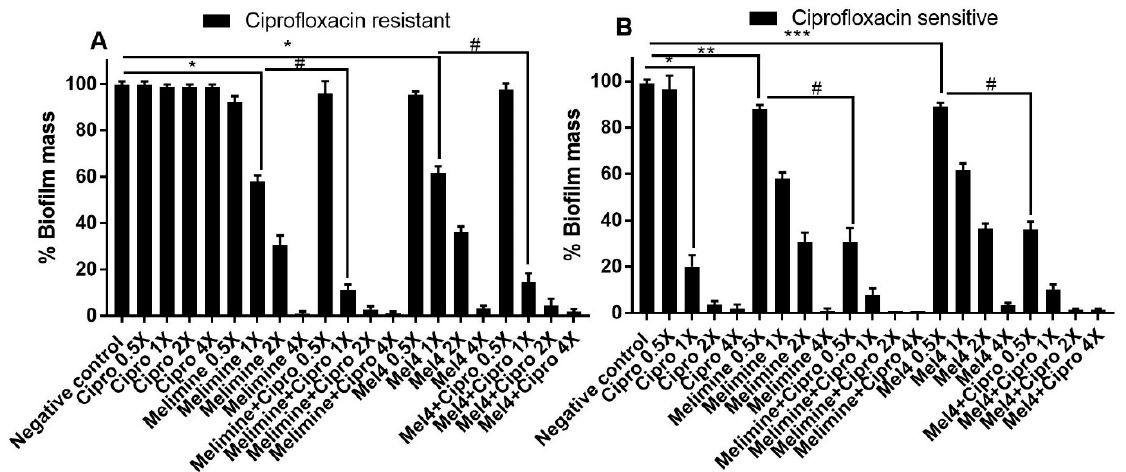
Figure 4. Disruption of pre-established biofilm of S. aureus ATCC. Biofilms of the ciprofloxacin-resistant ( A ) and sensitive ( B ) cells of P. aeruginosa ATCC 27853 were disrupted at various concentrations by melimine, Mel4 and ciprofloxacin alone or in combination. * represents significant ( p < 0.001), ** indicates significant ( p = 0.005), *** indicates significant ( p = 0.022) decrease compared to the negative control (biofilm treated with buffer). # indicates significant ( p < 0.001) decrease for the combinations compared to melimine or Mel4 alone. Error bars represent means ( ± SD) of three independent repeats in triplicate. Negative control = bacteria grown in the absence of antimicrobials. Cipro = ciprofloxacin.